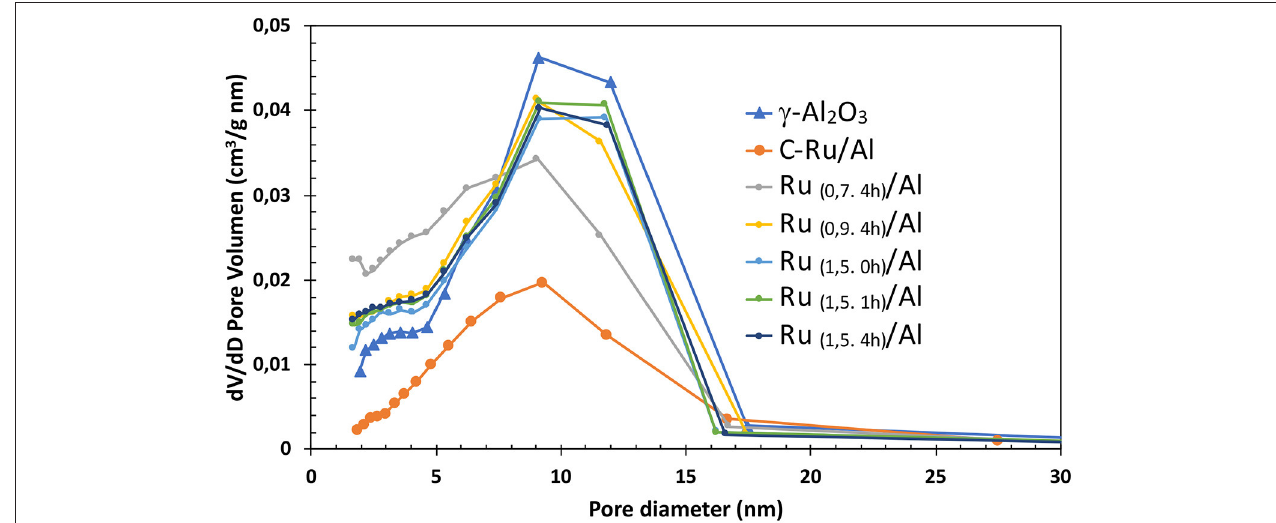
FIGURE 2 | Solids pore size distribution: Al 2 O 3 , Ru/Al commercial and synthesized.